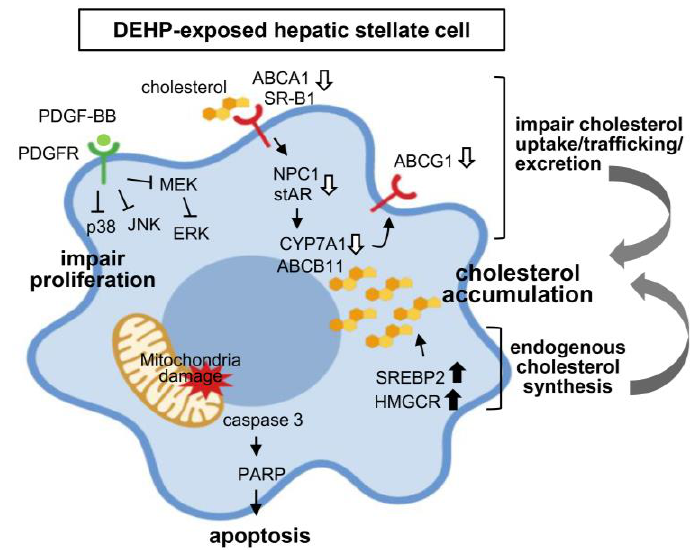
Figure 8. Proposed mechanisms of long-term, low-dose DEHP exposure on hepatic stellate cell (HSC) activation and liver fibrosis.